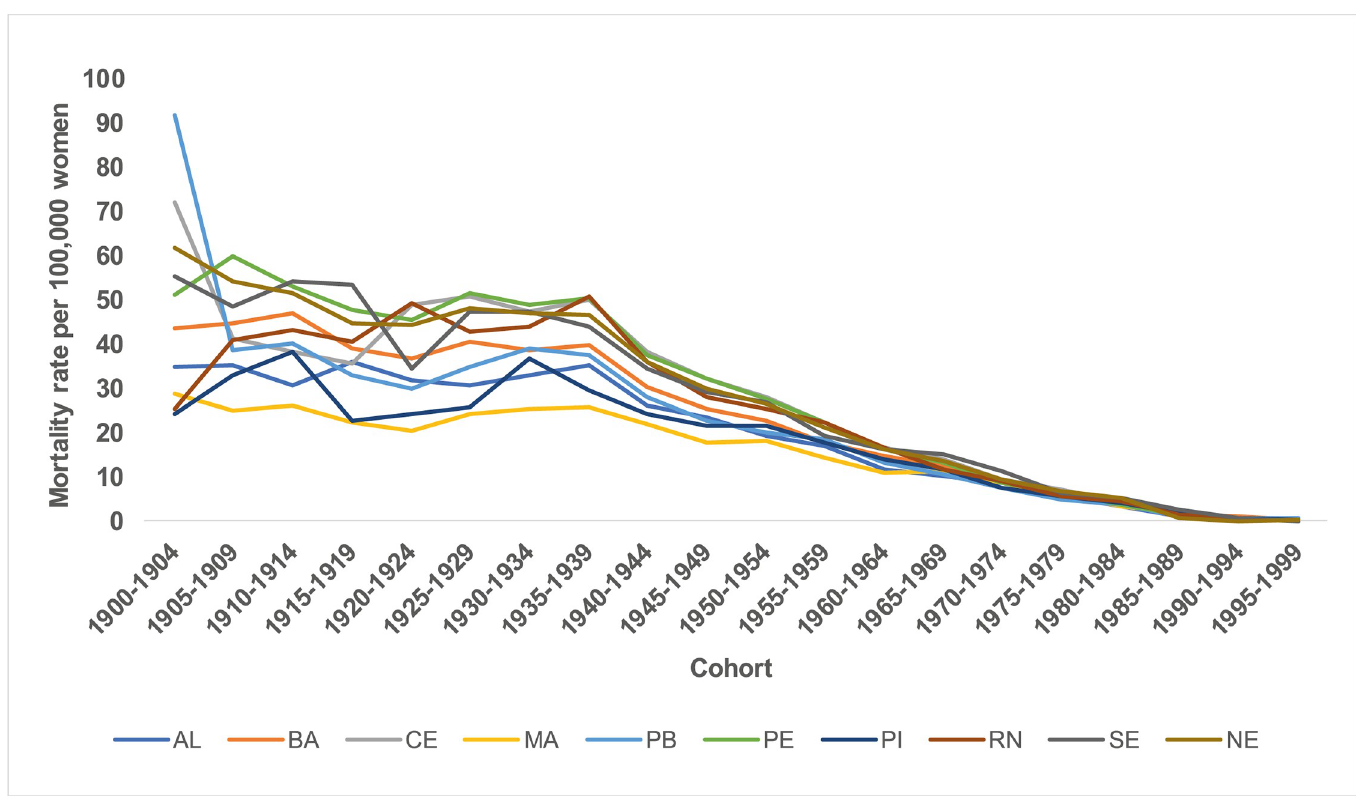
Fig 6. Distribution of mean mortality rates observed for breast cancer according to cohort groups in Northeast States, Brazil, 1980–2019.